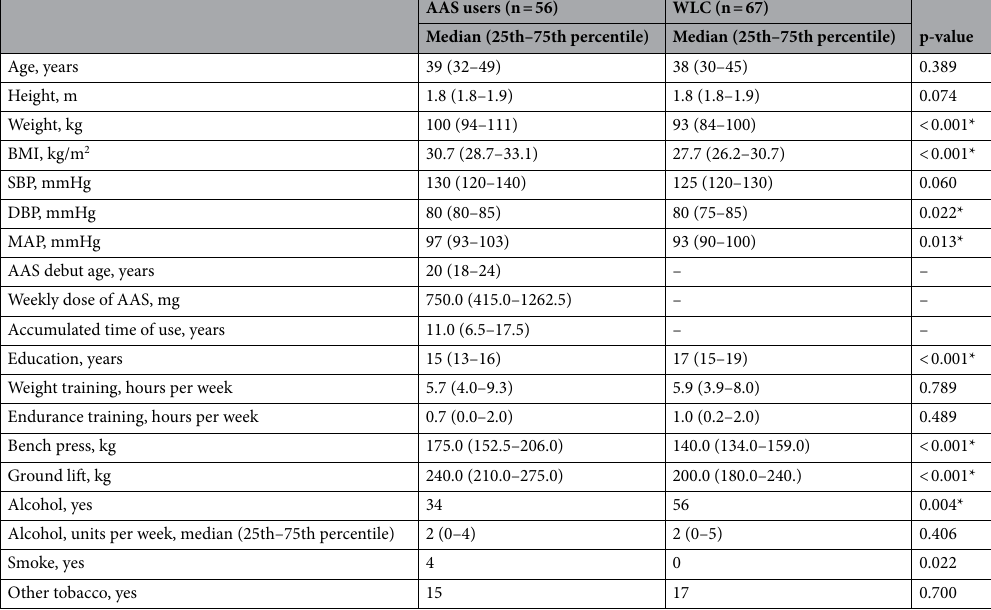
Table 1. Demographical data for the study subjects. AAS anabolic androgenic steroids, WLC weight lifting controls, BMI body mass index, SBP systolic blood pressure, DBP diastolic blood pressure, MAP mean arterial pressure. *Significant difference between